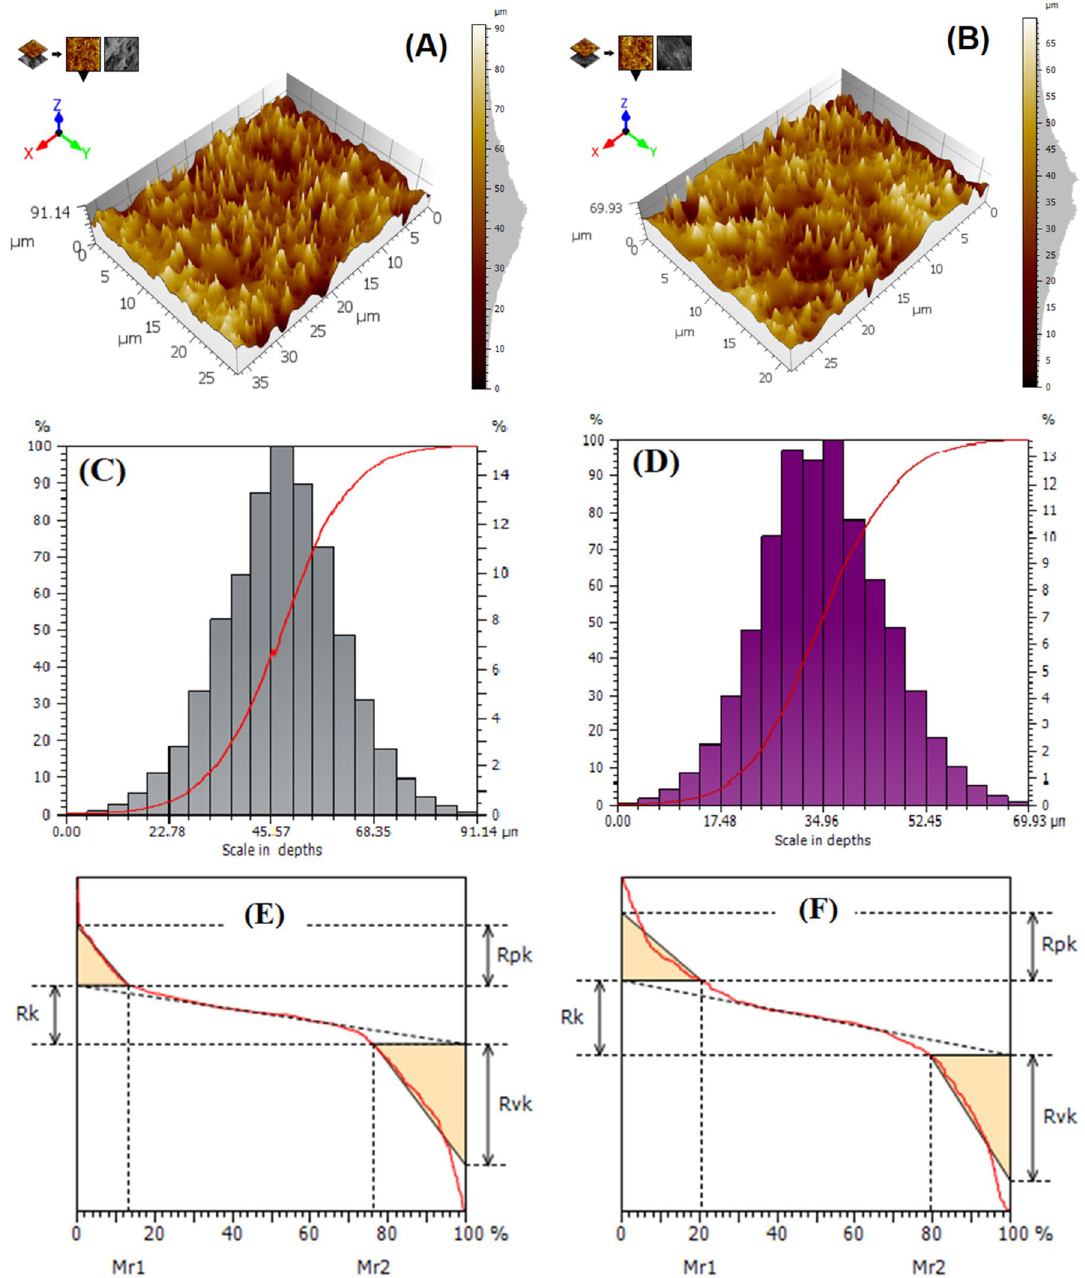
Figure 4. 3D images ( A ) before adsorption, and ( B ) after adsorption, the depth histograms and Abbott– Firestone curves ( C ) before adsorption, and ( D ) after adsorption, and schematic representation of a bearing area curve as well as the related roughness parameters ( E ) before adsorption, and ( F ) after adsorption for Zn–Mg– Al/LDH